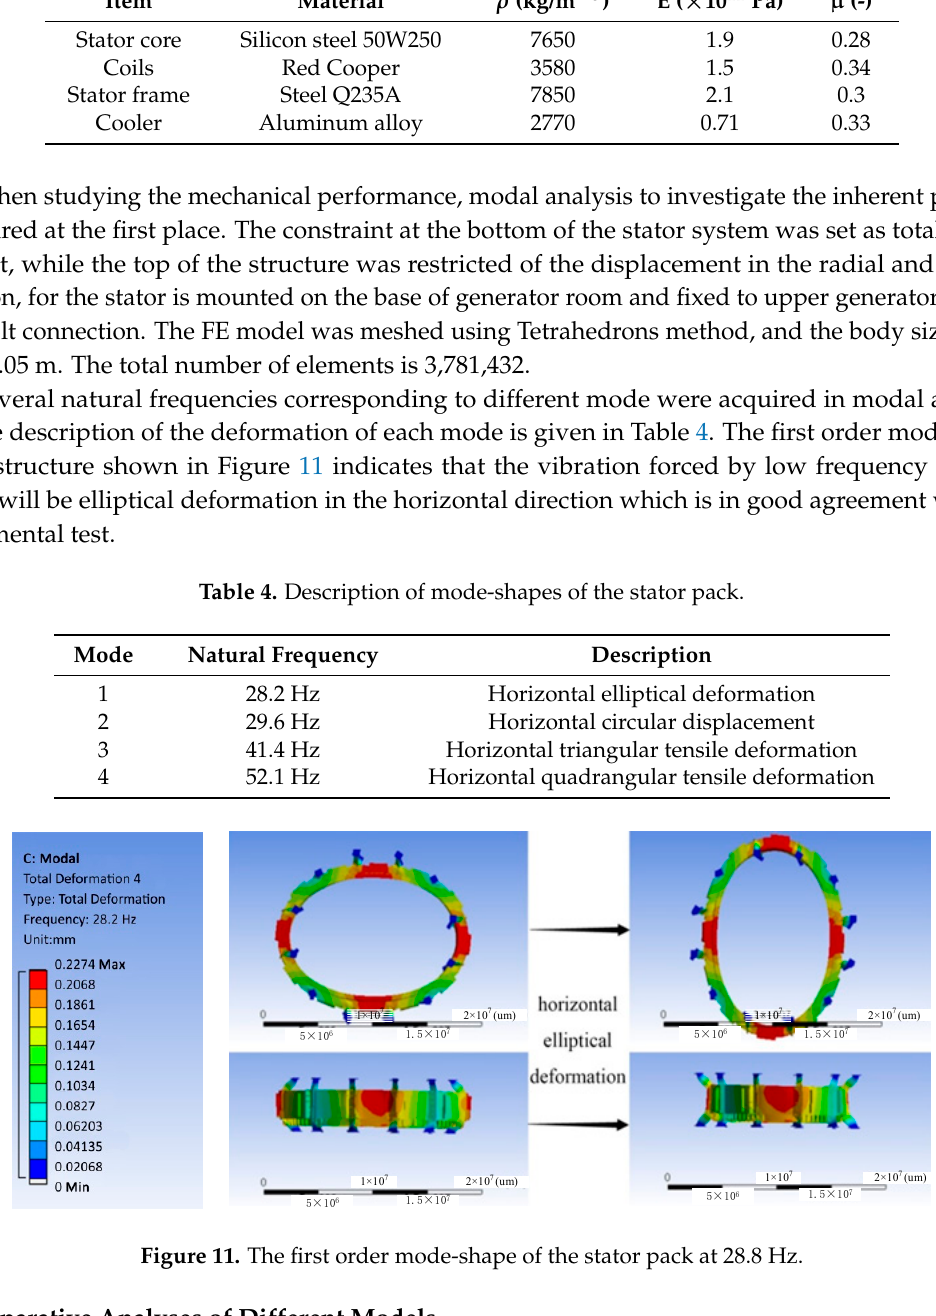
Table 3. Material characteristics.